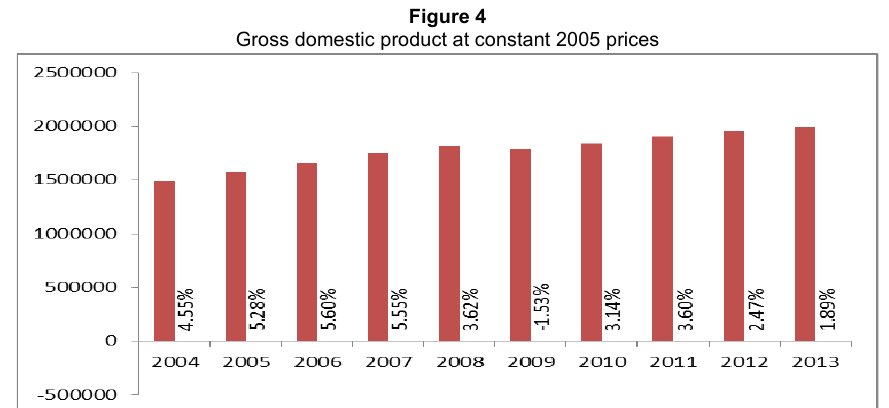
Figure 4 Gross domestic product at constant 2005 prices